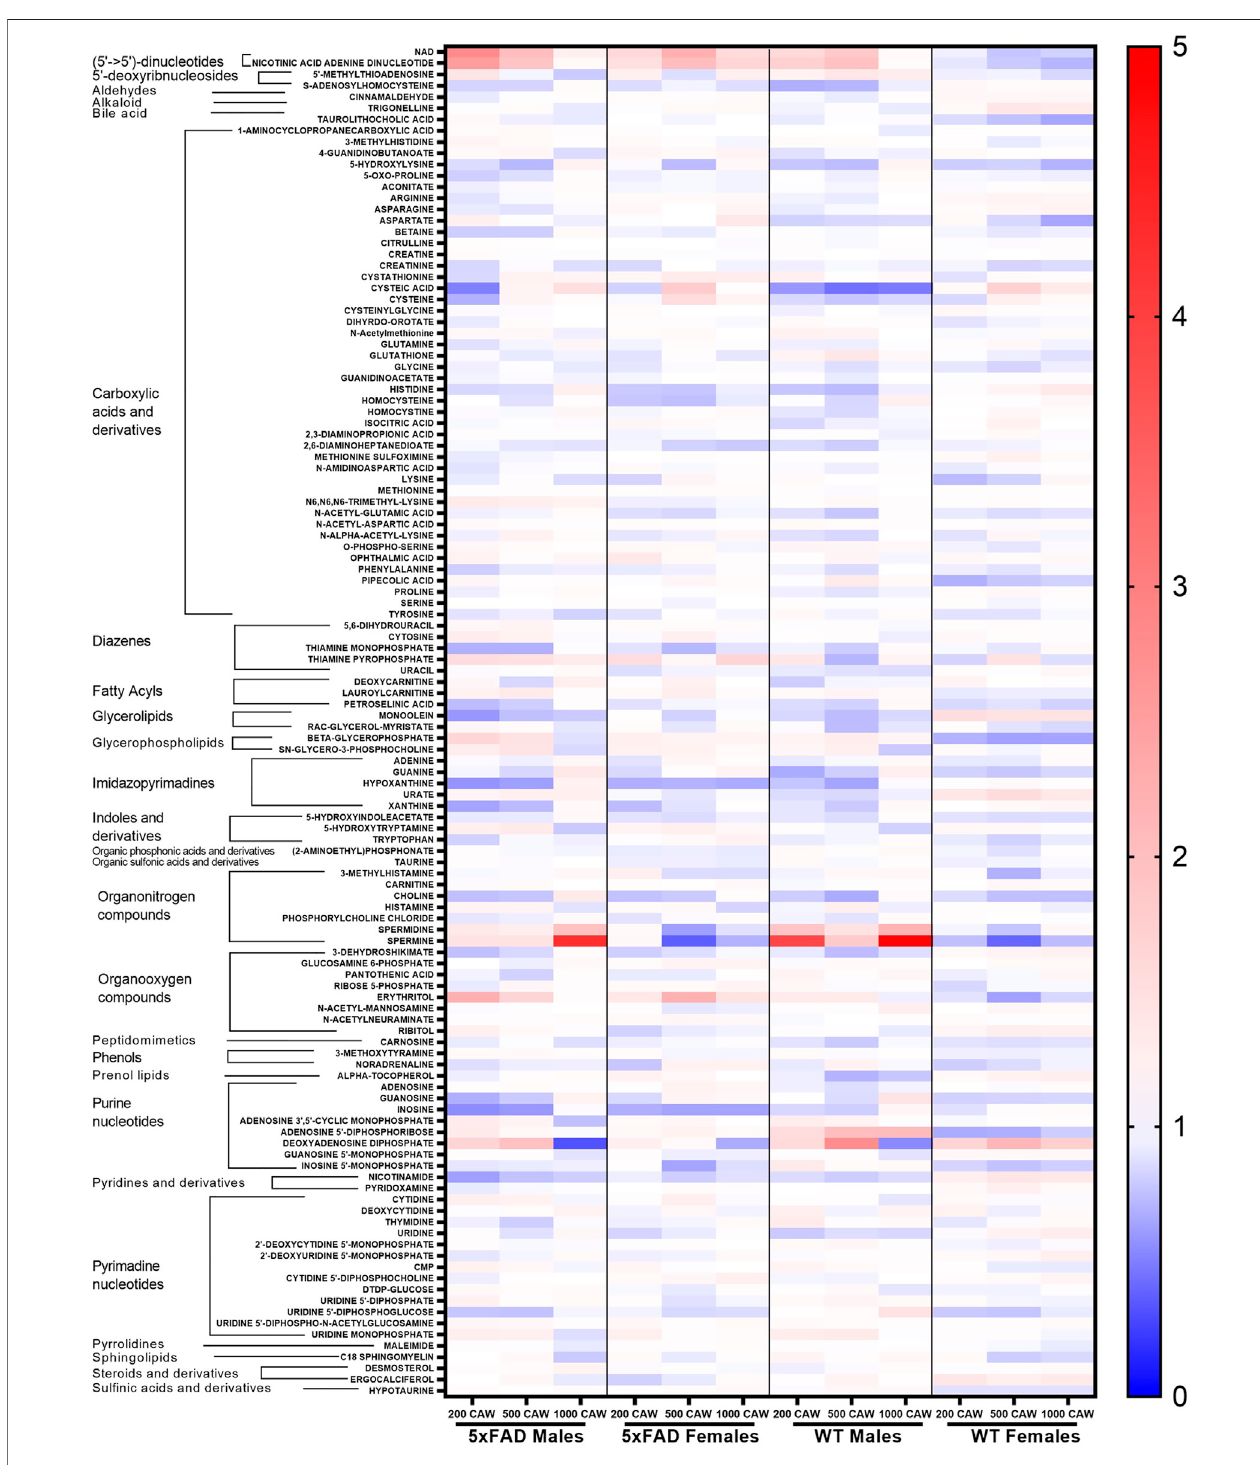
FIGURE 5 | Heatmap of changes in identi fi ed metabolites in the cortex of male and female 5xFAD and wild-type (WT) mice treated with CAW (200, 500, and or 1,000 mg/kg) compared to untreated animals of the same genotype and gender.